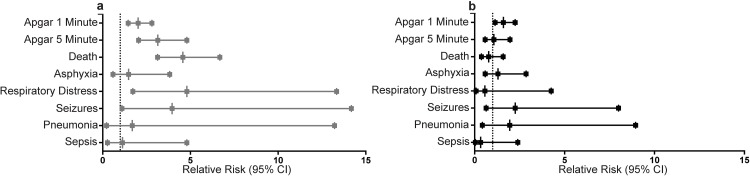
Low placental weight is associated with an increased risk of adverse perinatal outcomes.Forest plots of adjusted relative risk for perinatal outcomes with placental weight in (a) the bottom tenth percentile and (b) the top tenth percentile. Forest plots depict adjusted relative risk and 95% confidence interval. Multivariate models adjusted for treatment arm (placebo, multivitamin), maternal age (years), sex of child (male, female), gestational age at trial enrolment (weeks), and gestational age at delivery (week).